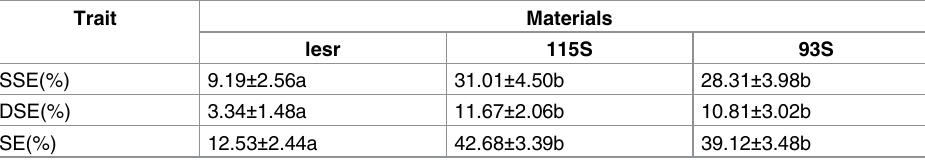
Different lower letters indicate significant difference (P <